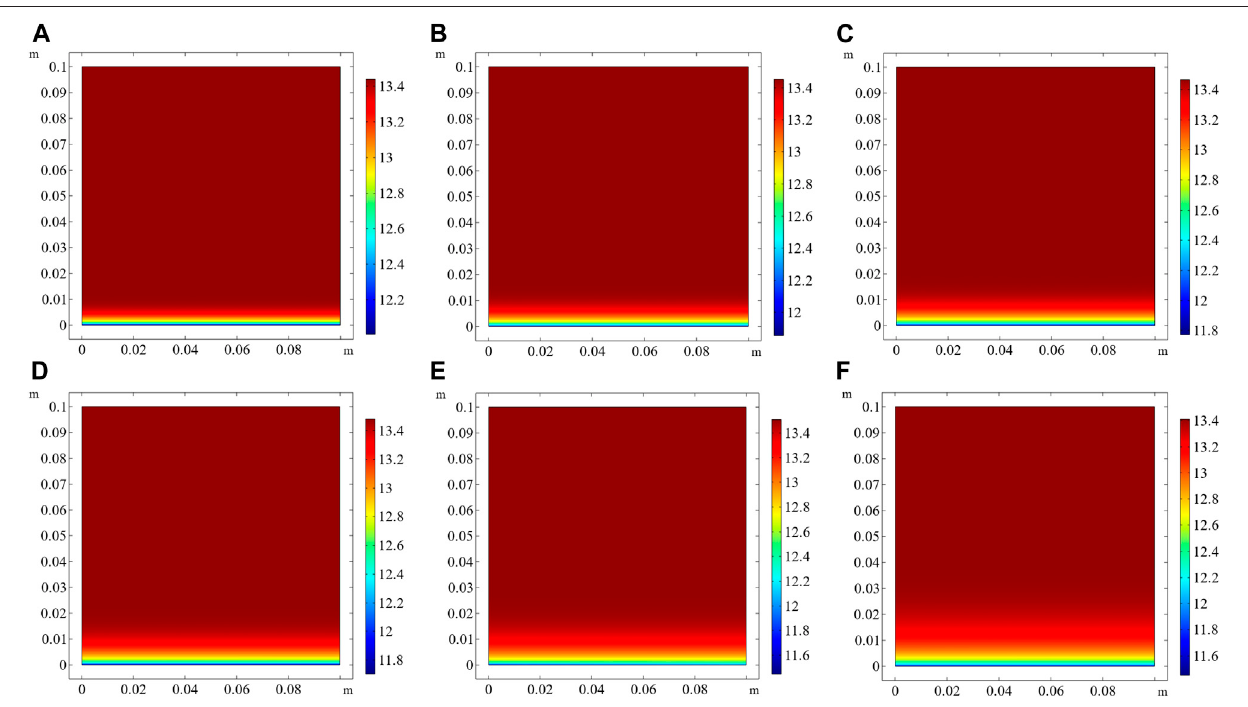
FIGURE 5 | pH in the pore solution of CAC at different exposure times. (A) 30 days, (B) 60 days, (C) 90 days, (D) 120 days, (E) 180 days, (F) 360 days.